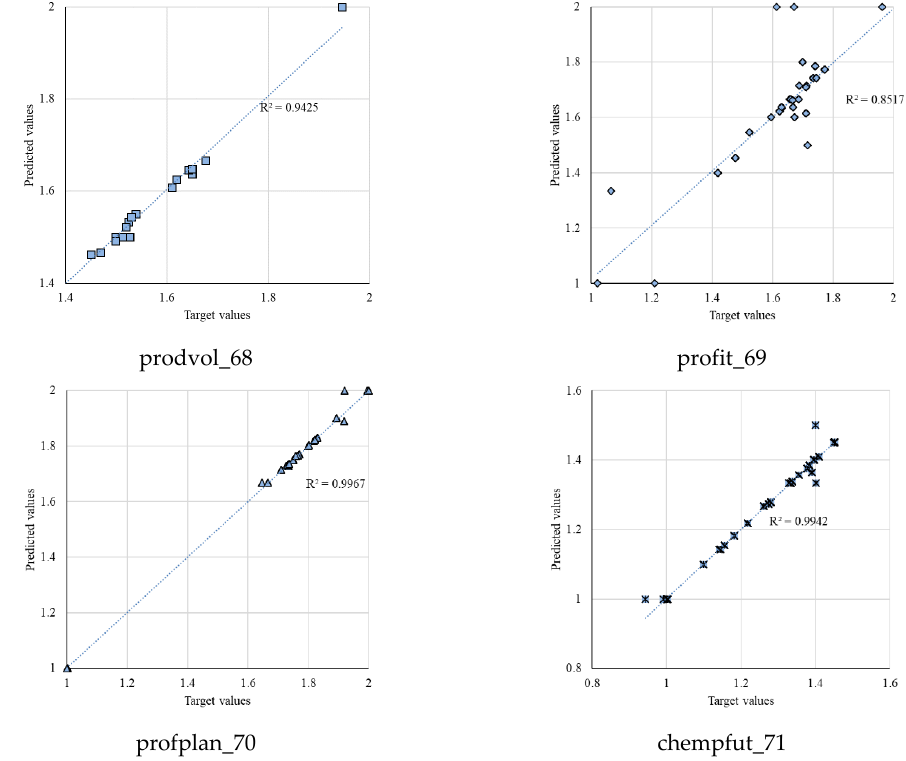
Figure 9. Plot diagrams for the effects of employee voice on output values of firm performance.